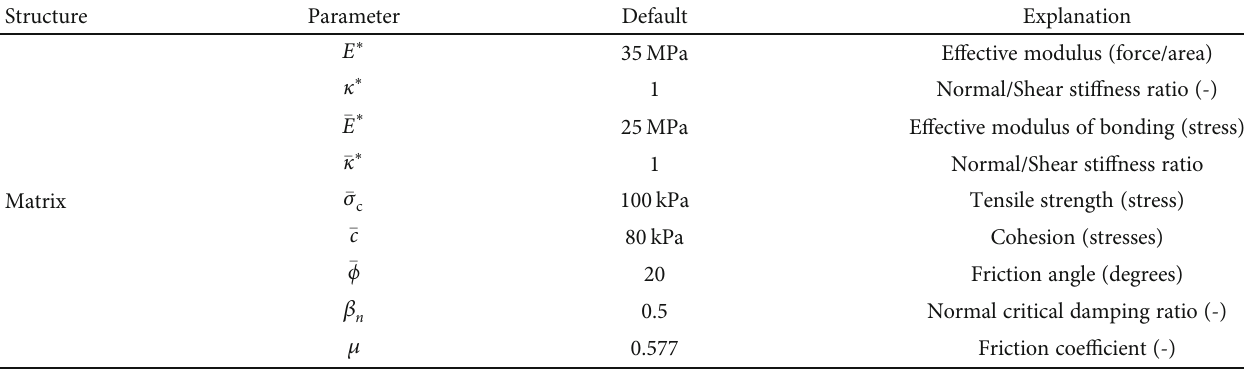
Table 1: Simulation parameters of the rock matrix.